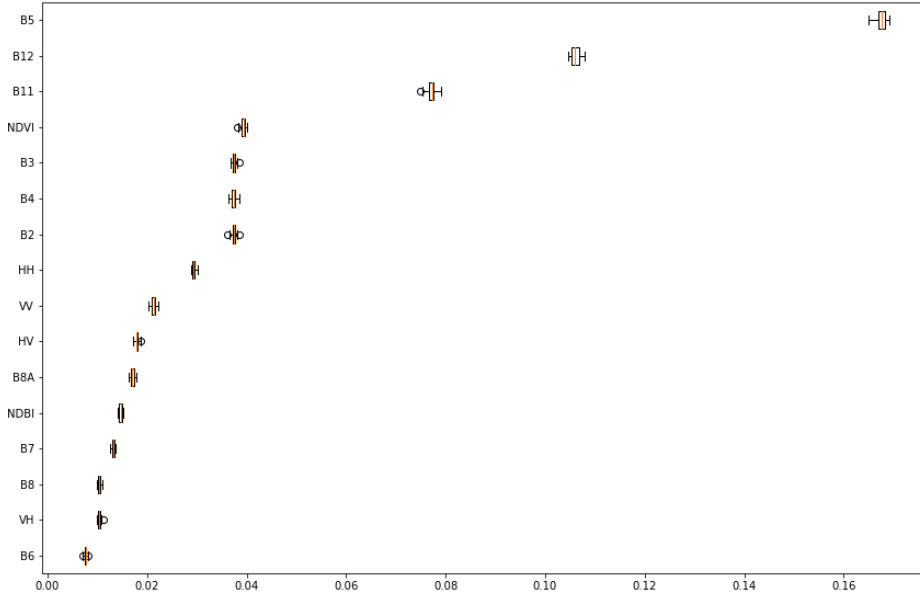
Figure 9. The variable importance of extracted features of Sentinel-1 and Sentinel-2 on the final coastal wetland classification by the RF classifier based on the Gini importance index.